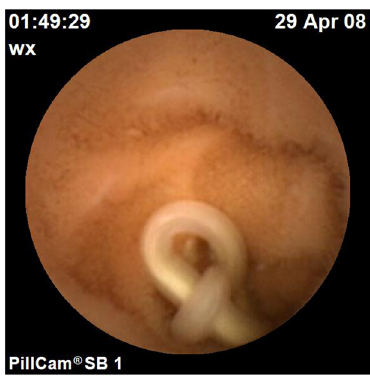
Figure 5. An eminence lesion identified by CE. An eminence lesion was identified by CE in the small bowel of a 30-year-old man with periumbilial pain. The lesion was surgically diagnosed as gastrointes- tinal stromal tumor.